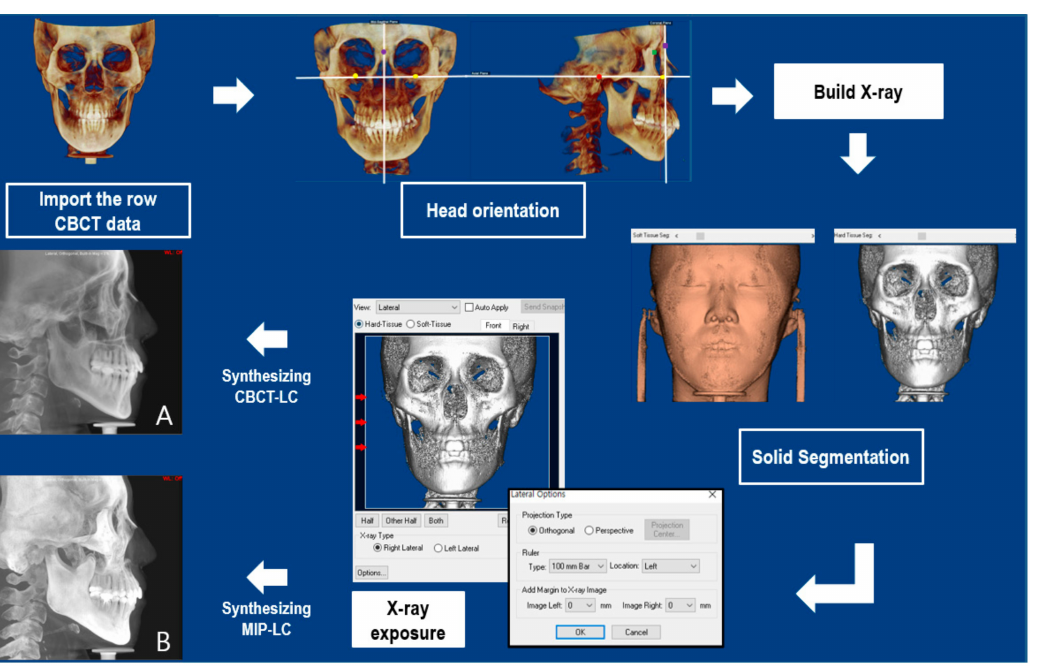
Figure 1. Image acquisition from CBCT: Import the CBCT data to the Dolphin software and reorient the head image. Using the ‘Build X-ray’ function in the software to synthesize the CBCT lateral cephalogram (CBCT-LC) and CBCT MIP lateral cephalogram (MIP-LC) with orthogonal X-ray. All synthesized image data were saved with a range of pixel size width at 2048 pix and the height at 1755–1890 pix in the JPG